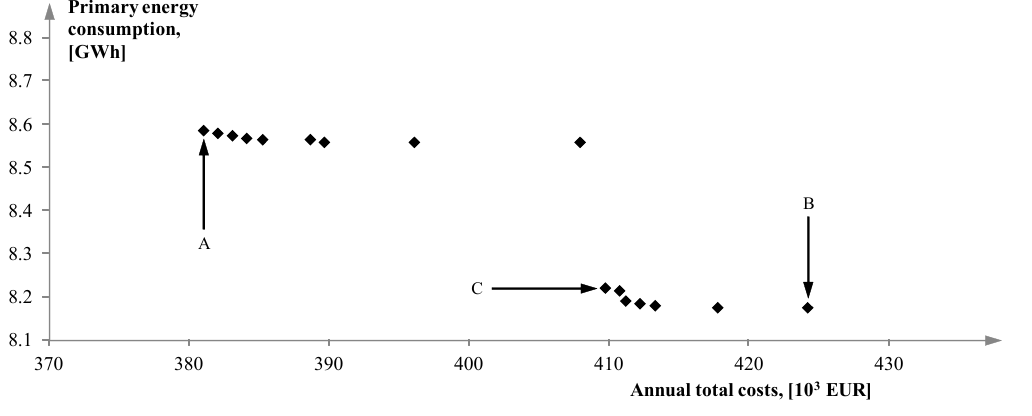
Figure 3. Optimal solutions of the multi-objective optimization